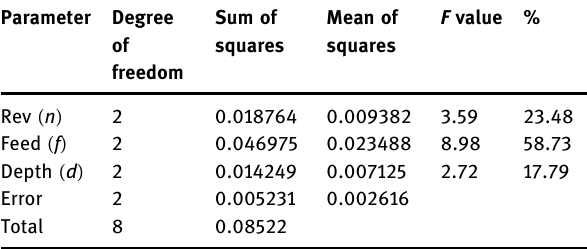
Table 8: Surface roughness ANOVA results of 0.8 mm tool